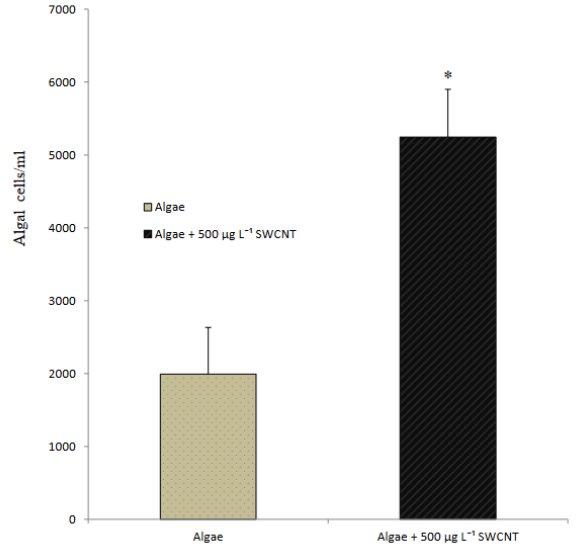
Figure 12. Mean (±SD) pseudofaeces production of mussels fed algae and 500 µg L − 1 SWCNTs alone, and in combination; * significantly different in pseudofaeces production of mussels fed algae and algae + 500 µg L − 1 SWCNTs (One Way ANOVA: F = 2.5217, df num = 1, means ± SD; n = 3; p = 0.008).